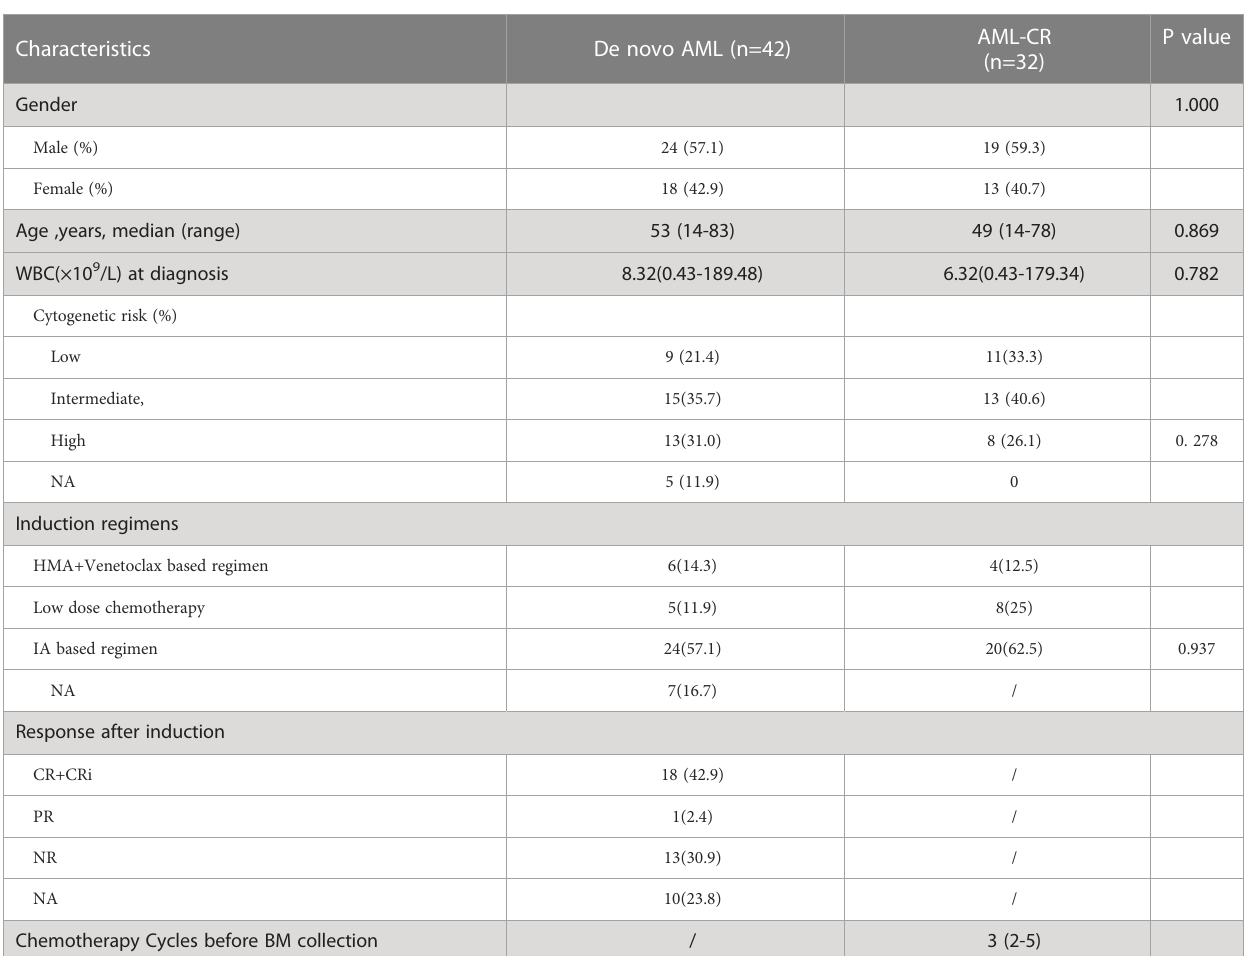
TABLE 1 Patient